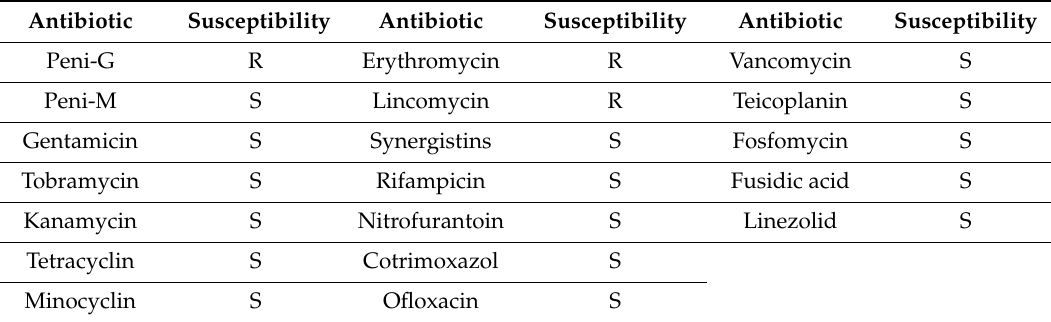
Figure 1. Clinical history of the case. ( A ) Schematic representation of the course of the infection and treatments. Left hip X-ray: ( B ) after osteosynthesis device ablation; ( C ) after prosthesis removal; and ( D ) after reimplantation. Table 1. Antibiogram of the S. argenteus PJI strain. R is for resistant and S is for sensitive according to the CASFM